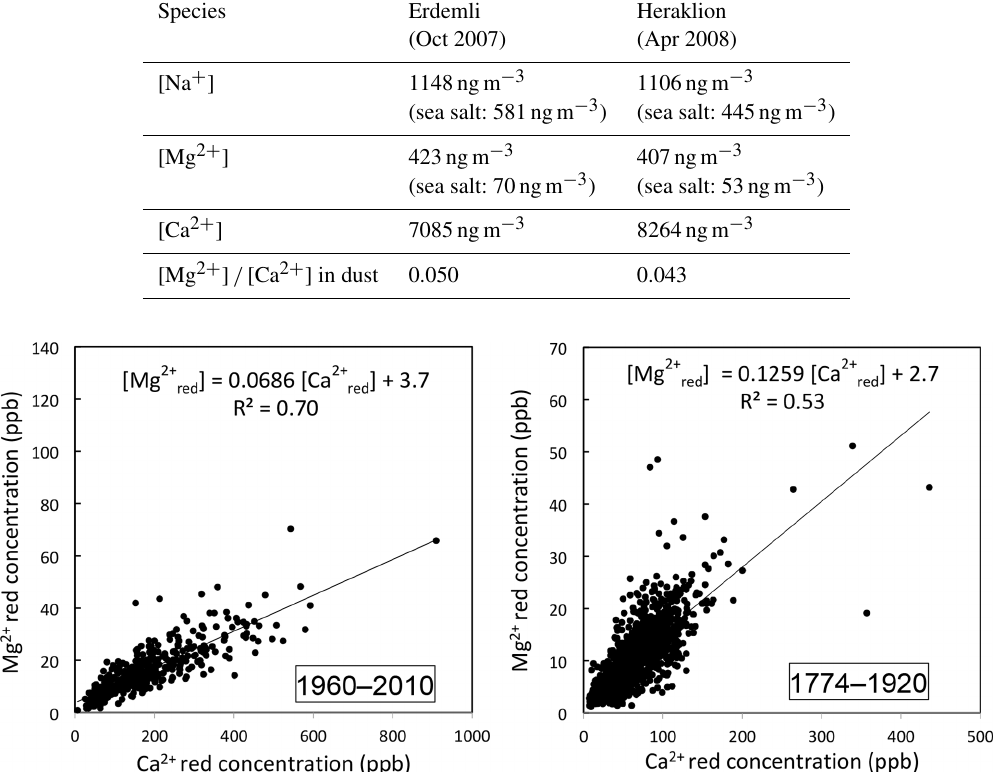
Figure 8. [Mg 2 + red . ] versus [Ca 2 + red . ] in individual Elbrus ice summer samples (not impacted by dust events) over the recent decades (left) and prior to the 1950 increase in